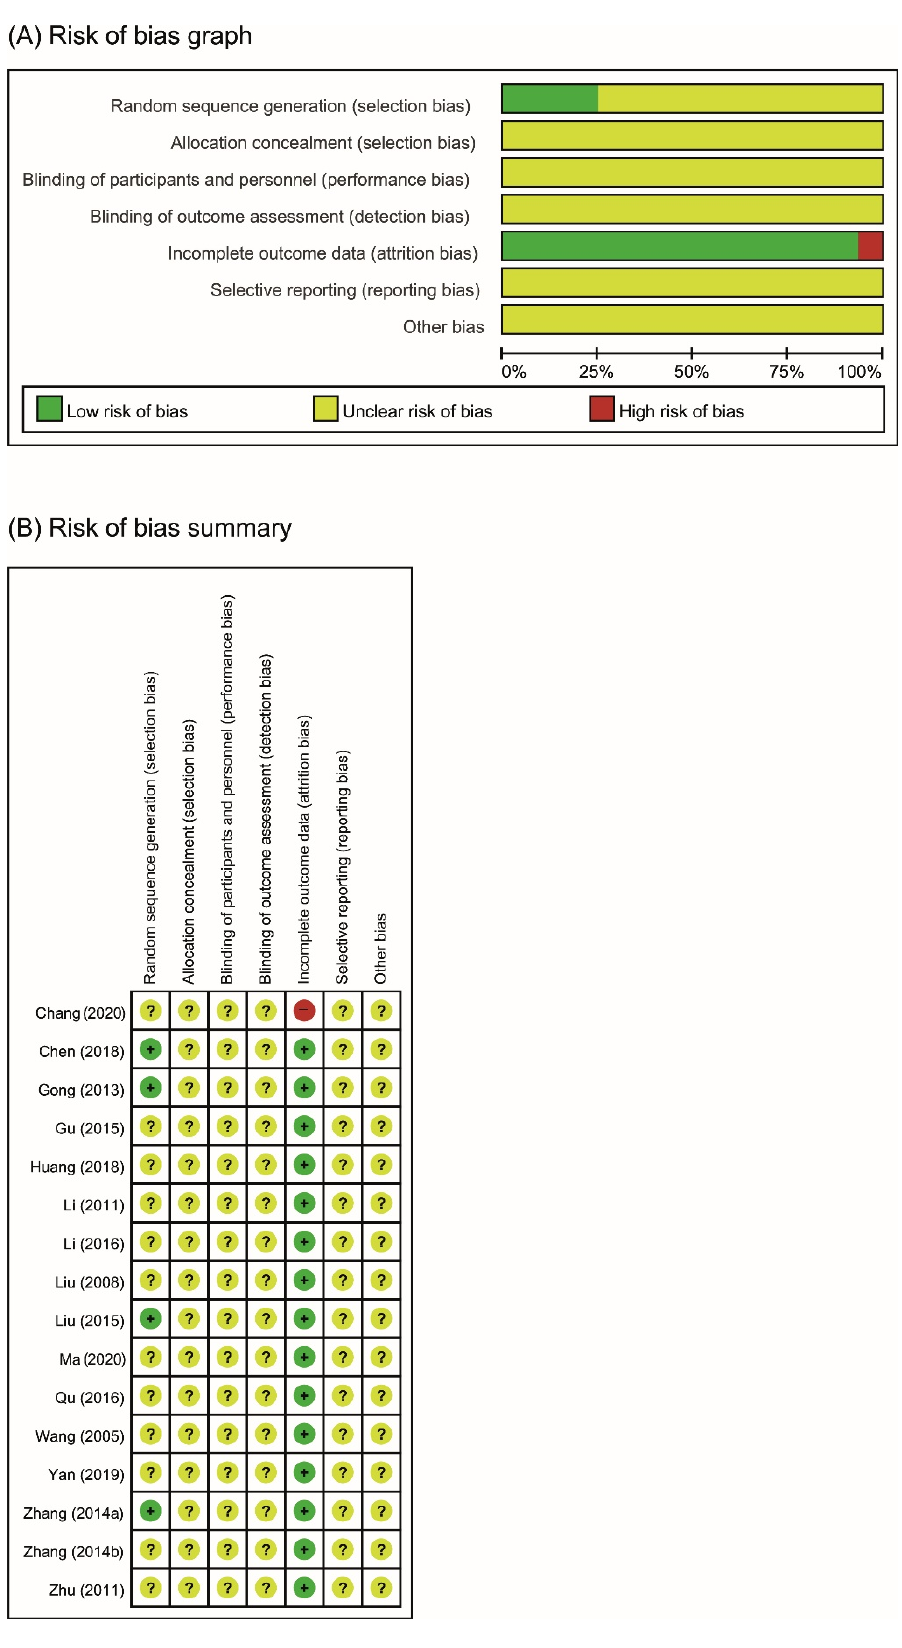
Figure 2. Risk of bias. ( A ) Risk of bias is shown as a graph: review authors’ judgments on each item’s risk of bias are presented as percentages across all included studies. ( B ) Risk of bias summary: review authors’ judgments on each item’s risk of bias for each included study. +: low risk of bias; − : high risk of bias; ?: unclear risk of bias.